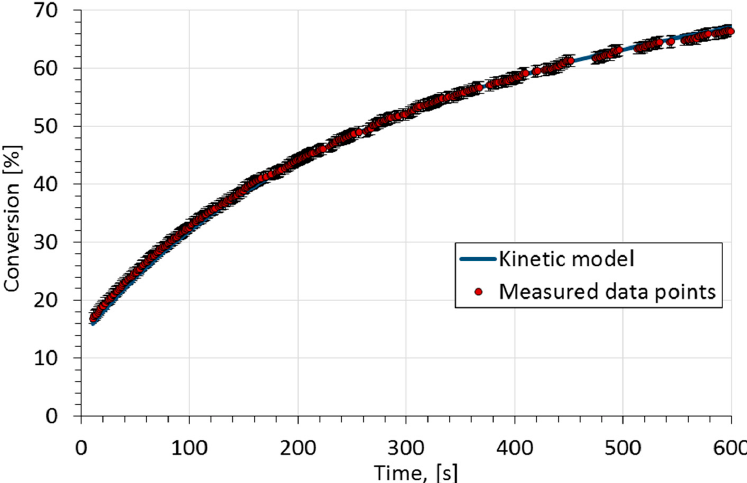
Figure 2. Measured conversion and modeling results for sodium hydroxide conversion at 17 °C.